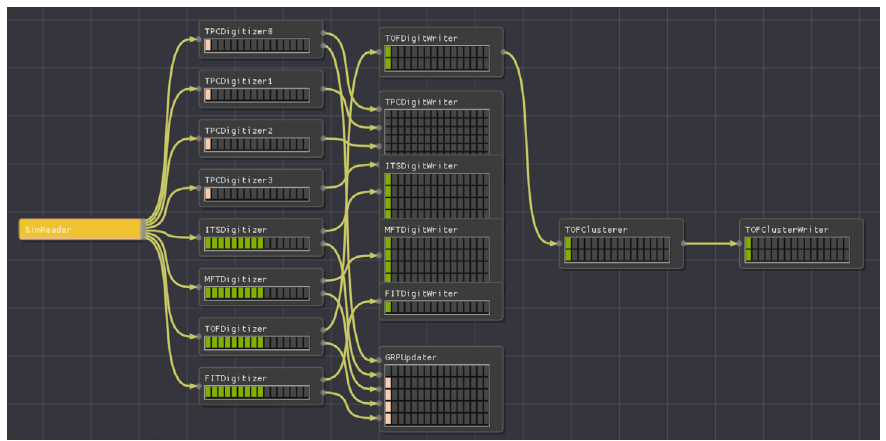
Figure 2. Digitization workflow on-going as shown in the topology viewer of debug GUI, running on